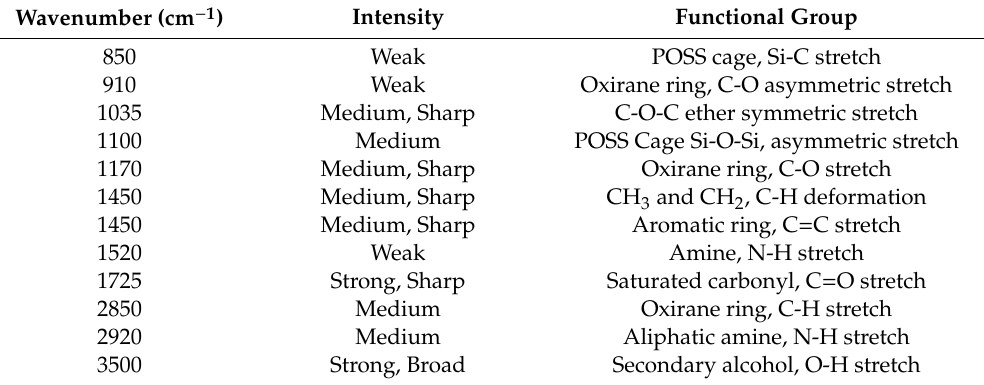
Figure 3. Infrared spectra of cured epoxy resin blends as a function of POSS content. Table 4. Characteristic FTIR (Fourier-transform infrared spectroscopy) of the absorbance bands for the cured 1 x 2 y 3 z samples (containing POSS).